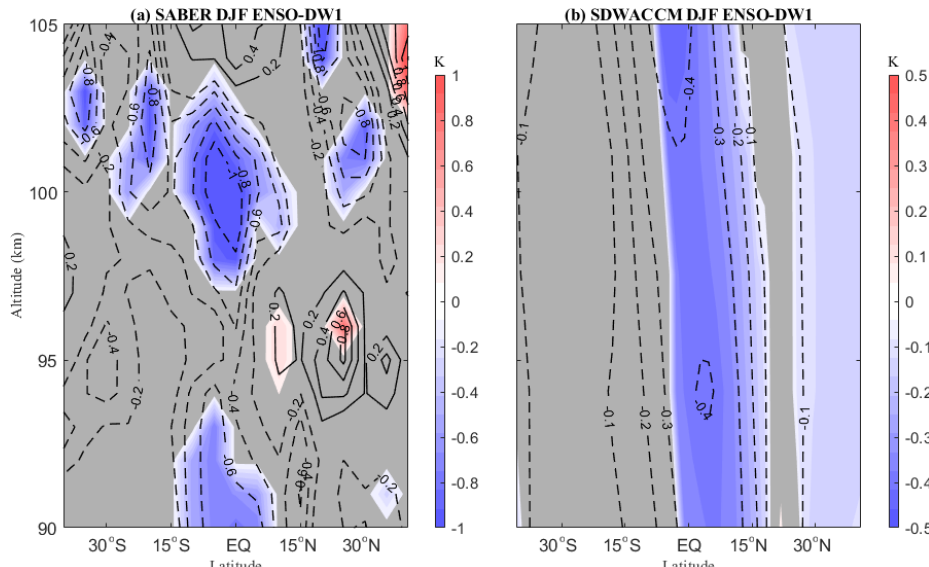
Figure 3. The linear regression coefficient of normalized Niño3.4 in SABER (a) and SD-WACCM (b) winter DW1-T. The contour interval is 0.2K for SABER and 0.1K for SD-WACCM. Solid lines and red shadings denote the positive responses, while dashed lines and blue shadings denote the negative responses; the grey regions indicate where the response is insignificant at the 95% level according to the F